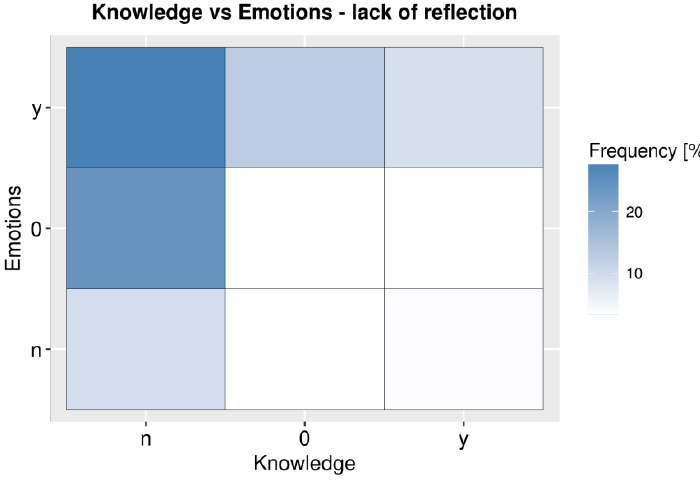
Figure 4. Frequency of responses compared between the knowledge and emotions dimensions—users without reflection (N).